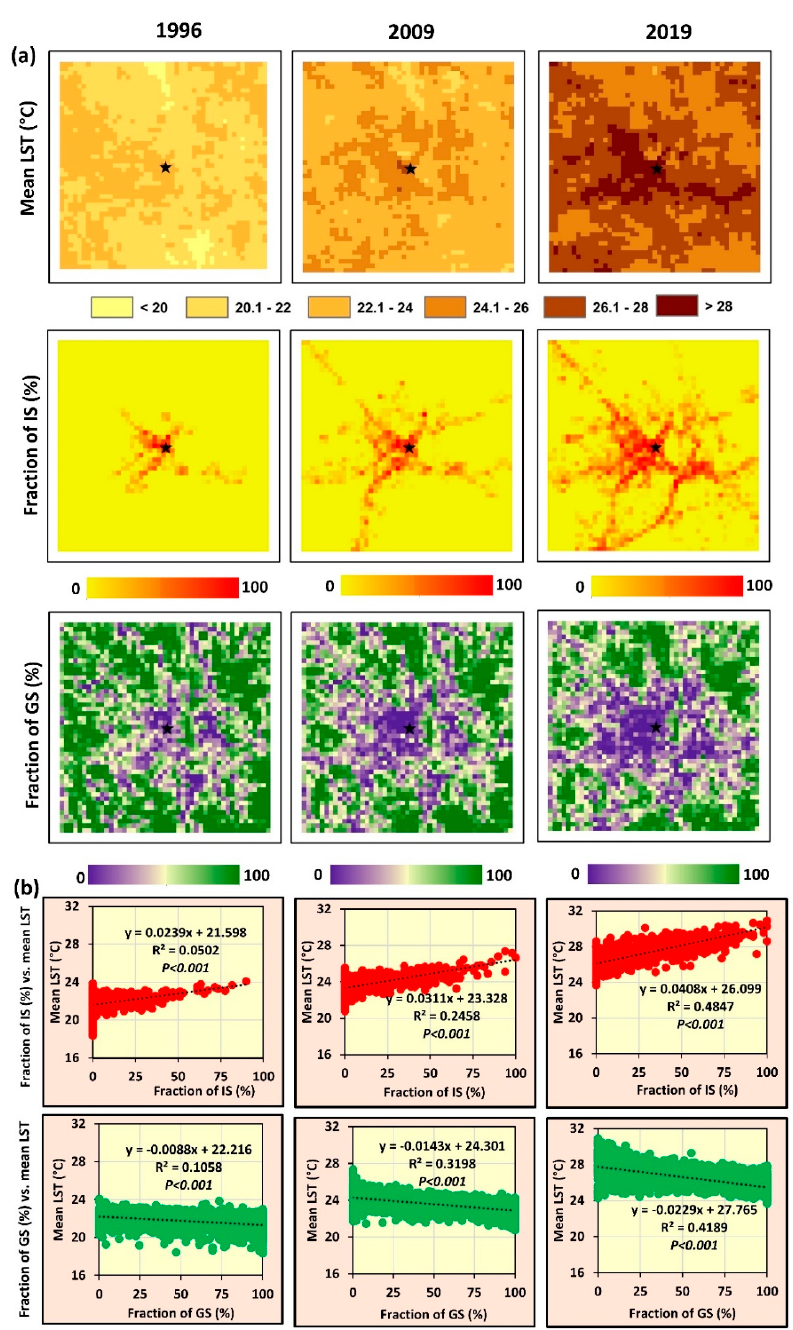
Figure 7. ( a ) Graphical view of the 210 × 210 m polygon grid showing maps of the Mean Land Surface Temperature (MLST), the fraction of IS (%) and the GS (%), ( b ) Scatterplots showing the relationship between the fraction of IS (%), GS (%) and mean LST in 1996, 2009 and 2019.